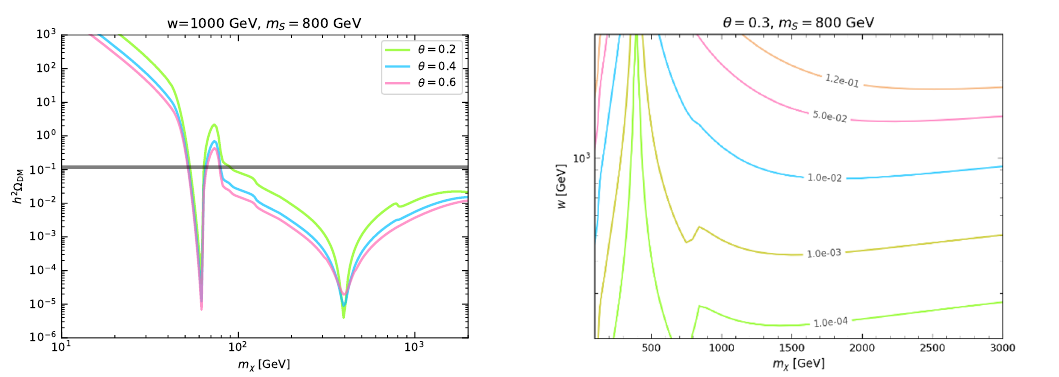
Figure 9 . Left plot: DM thermal relic density as a function of the DM mass for w = 1000 GeV, m S = 800 GeV, and (cid:18) = 0.2 (green), 0.4 (light blue) and 0.6 (green). The black line denotes the DM relic density given by the Planck satellite’s observation of the CMB radiation [104] Right plot: contours of the DM thermal relic density in the m (cid:31) - w plane for (cid:18) = 0 : 3 and m S = 800